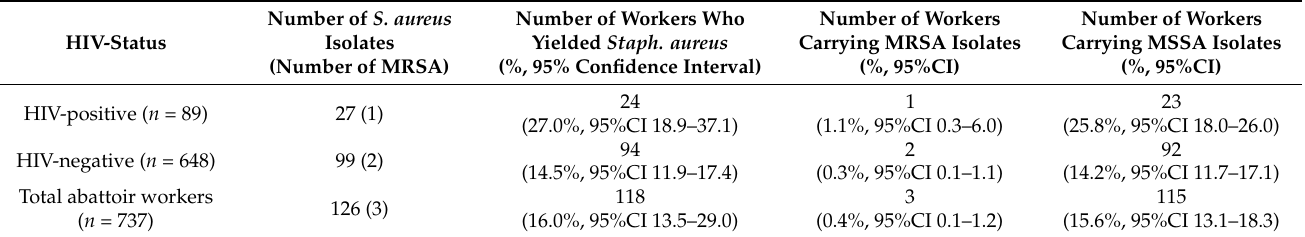
Table 1. Prevalence of MSSA and MRSA isolated from Abattoir workers in Busia